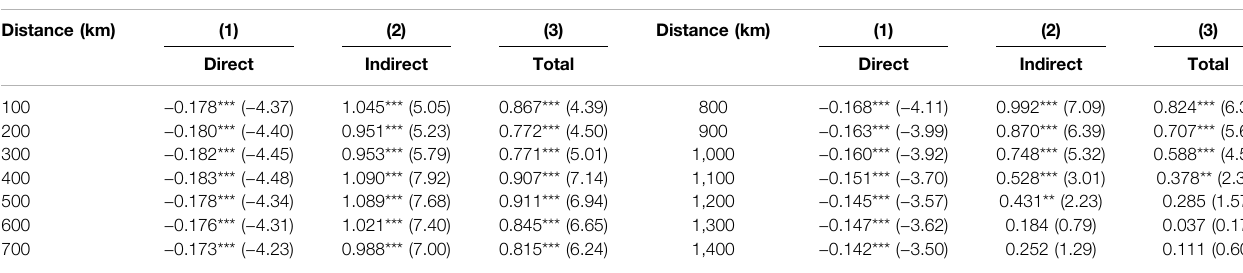
TABLE 6 | Spillover effect